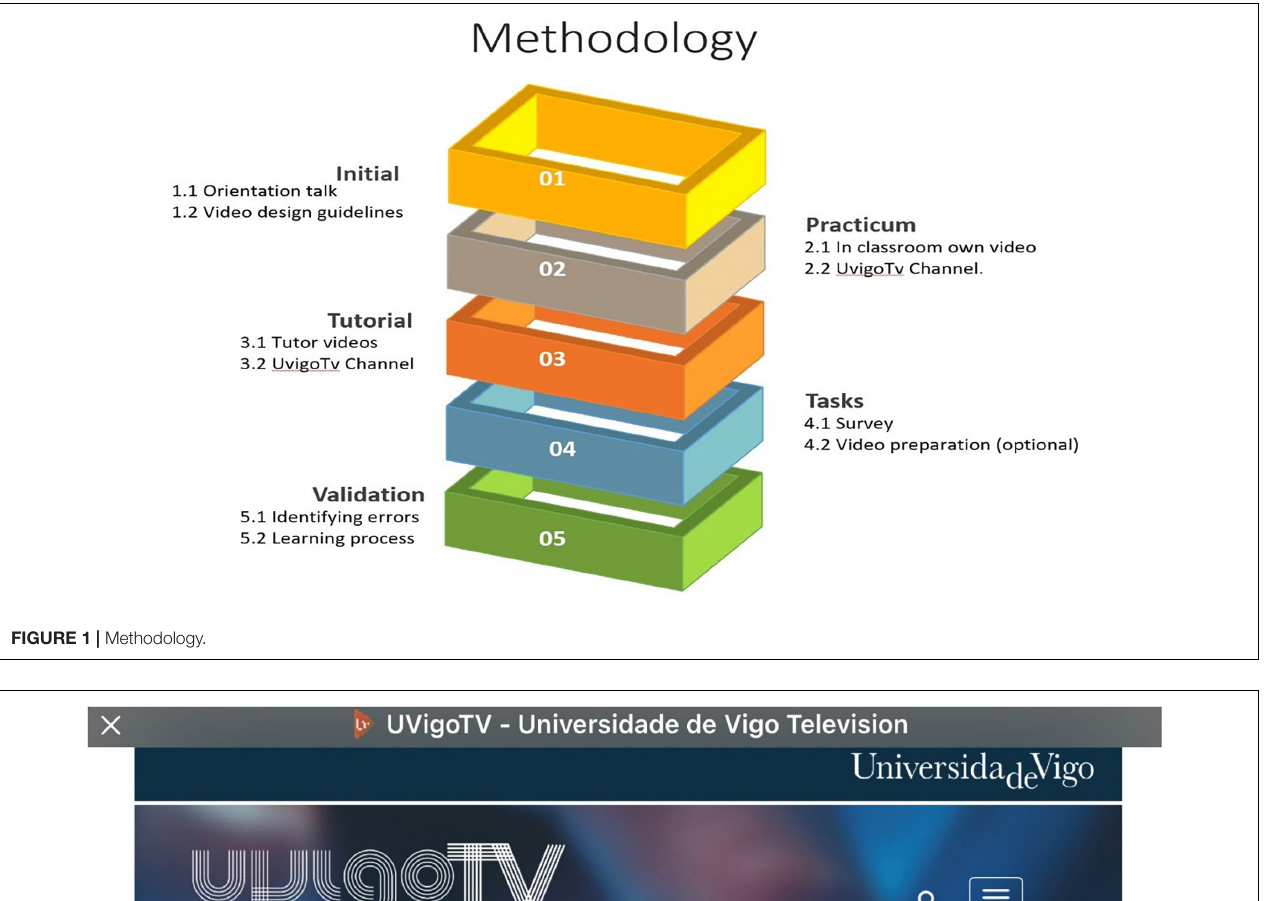
FIGURE 2 | UvigoTV on the